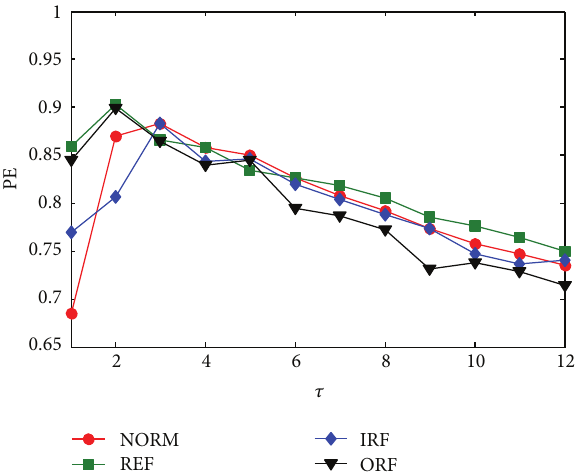
Figure 5: The time domain waveforms of normal and fault bearing vibration signals.